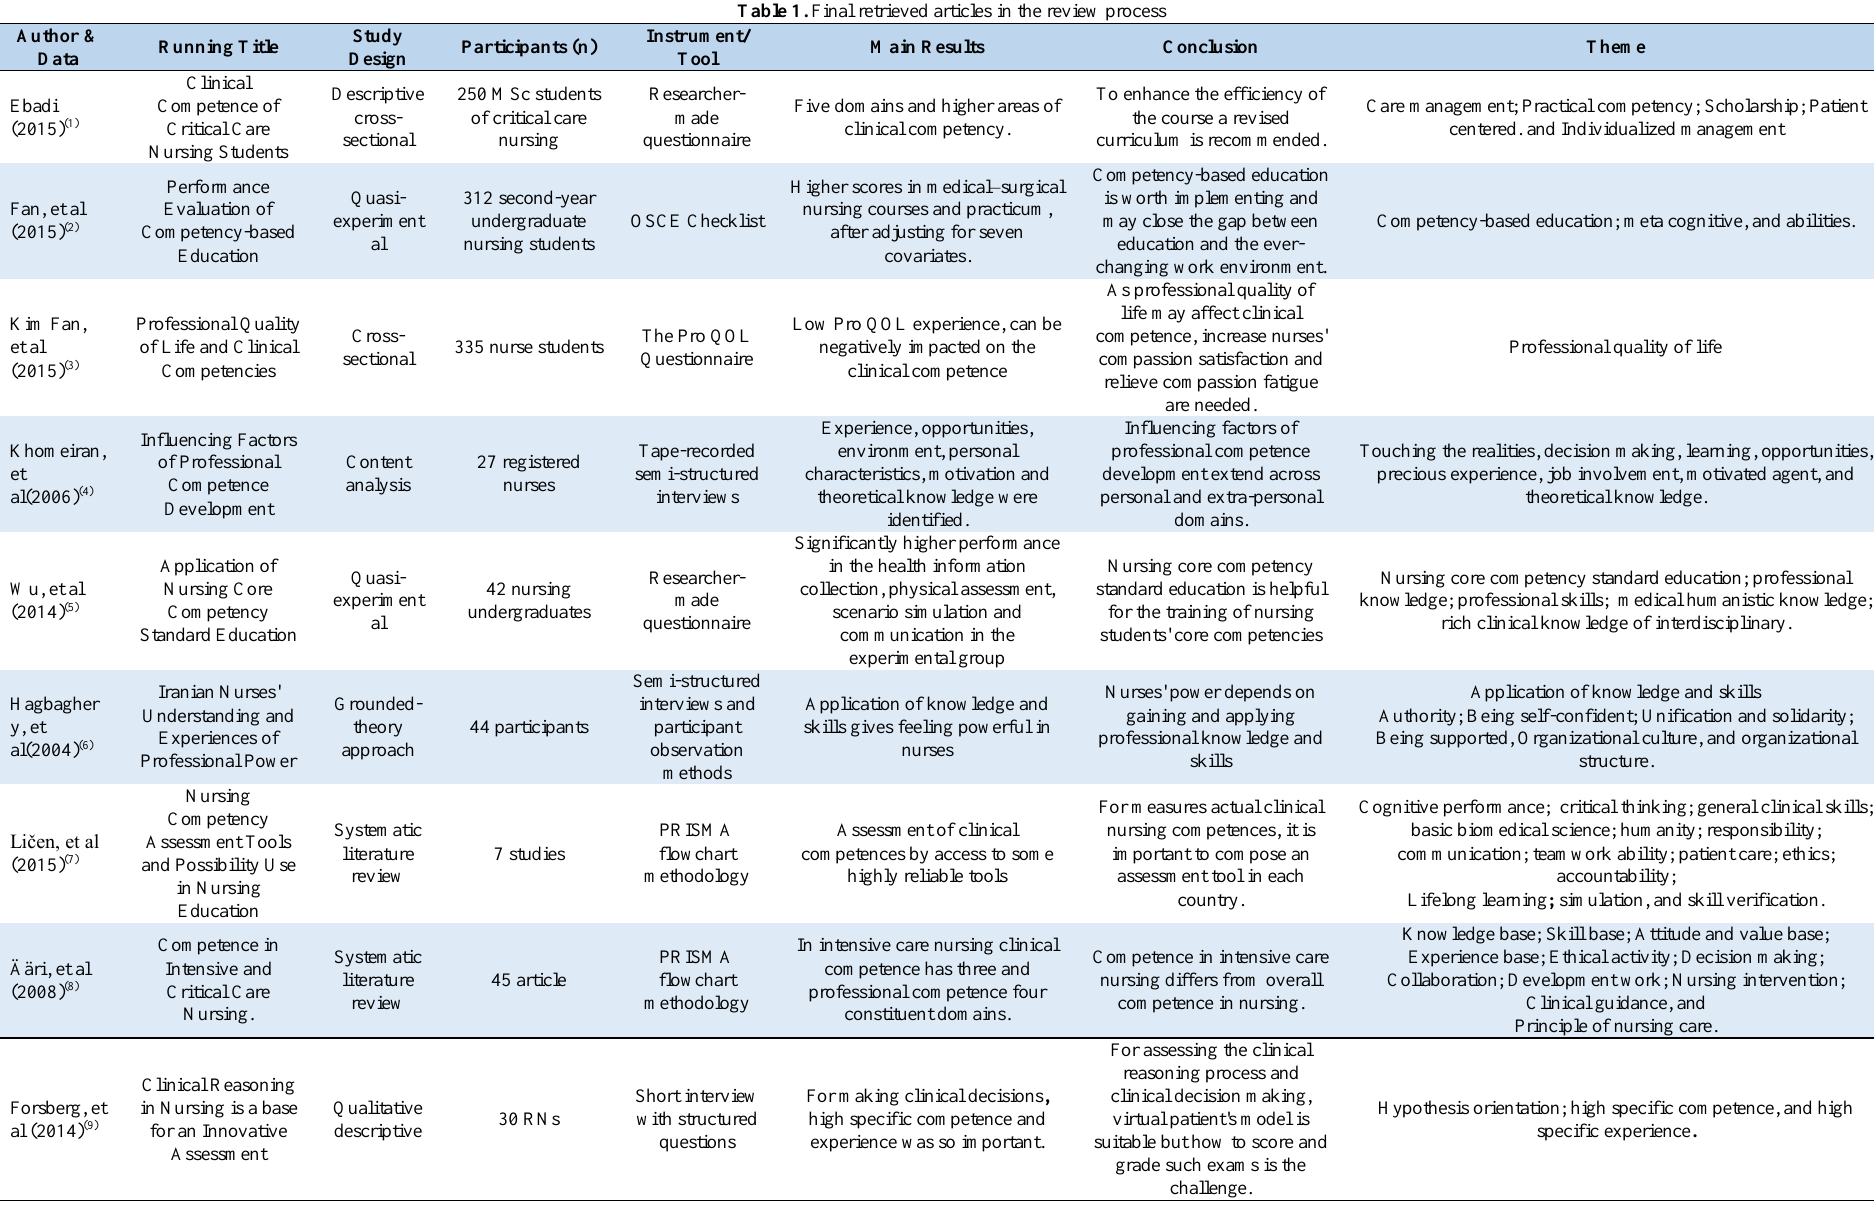
Theme Conclusion Main Results